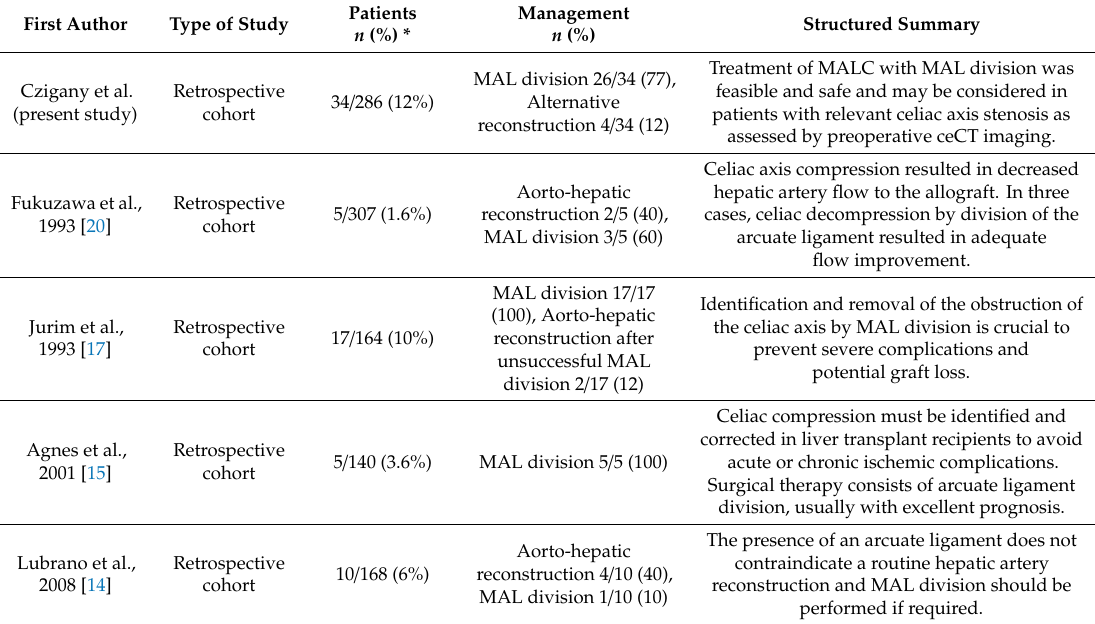
Table 3. Studies on median arcuate ligament compression (MALC) in orthotopic liver transplantation (search date: 20 March